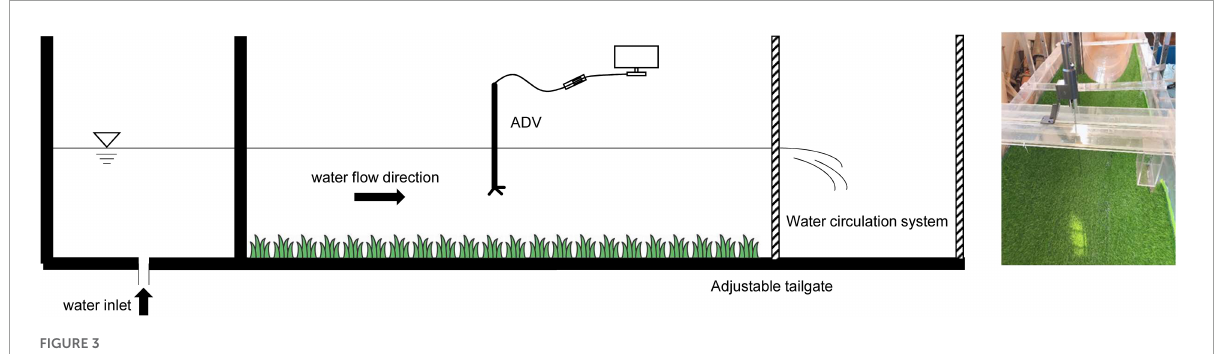
FIGURE3 Vegetated channel circulation system device